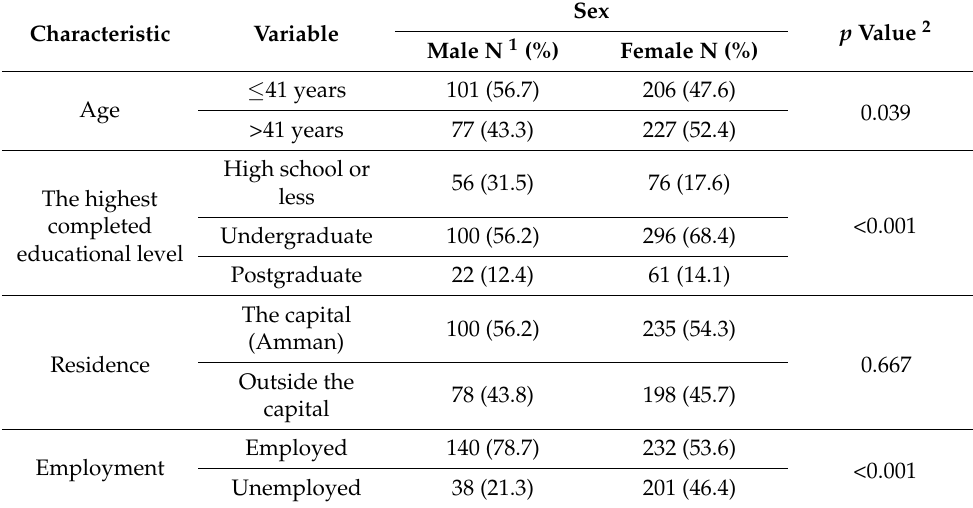
Table 2. Characteristics of the study sample stratified by